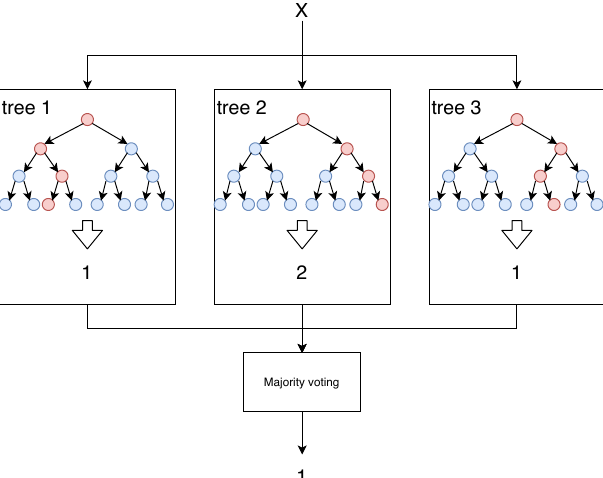
Figure 1. Random Forest example where each tree classifies the new instance and the resulting class is decided by majority voting.